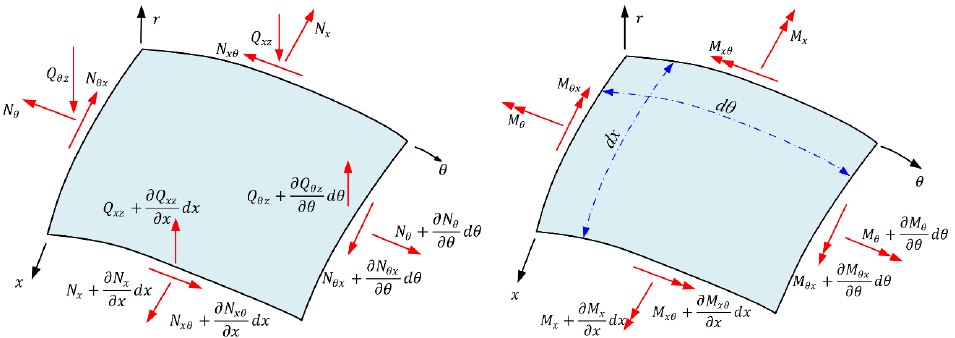
Figure 1. The force and moment distribution of laminated composite cylindrical